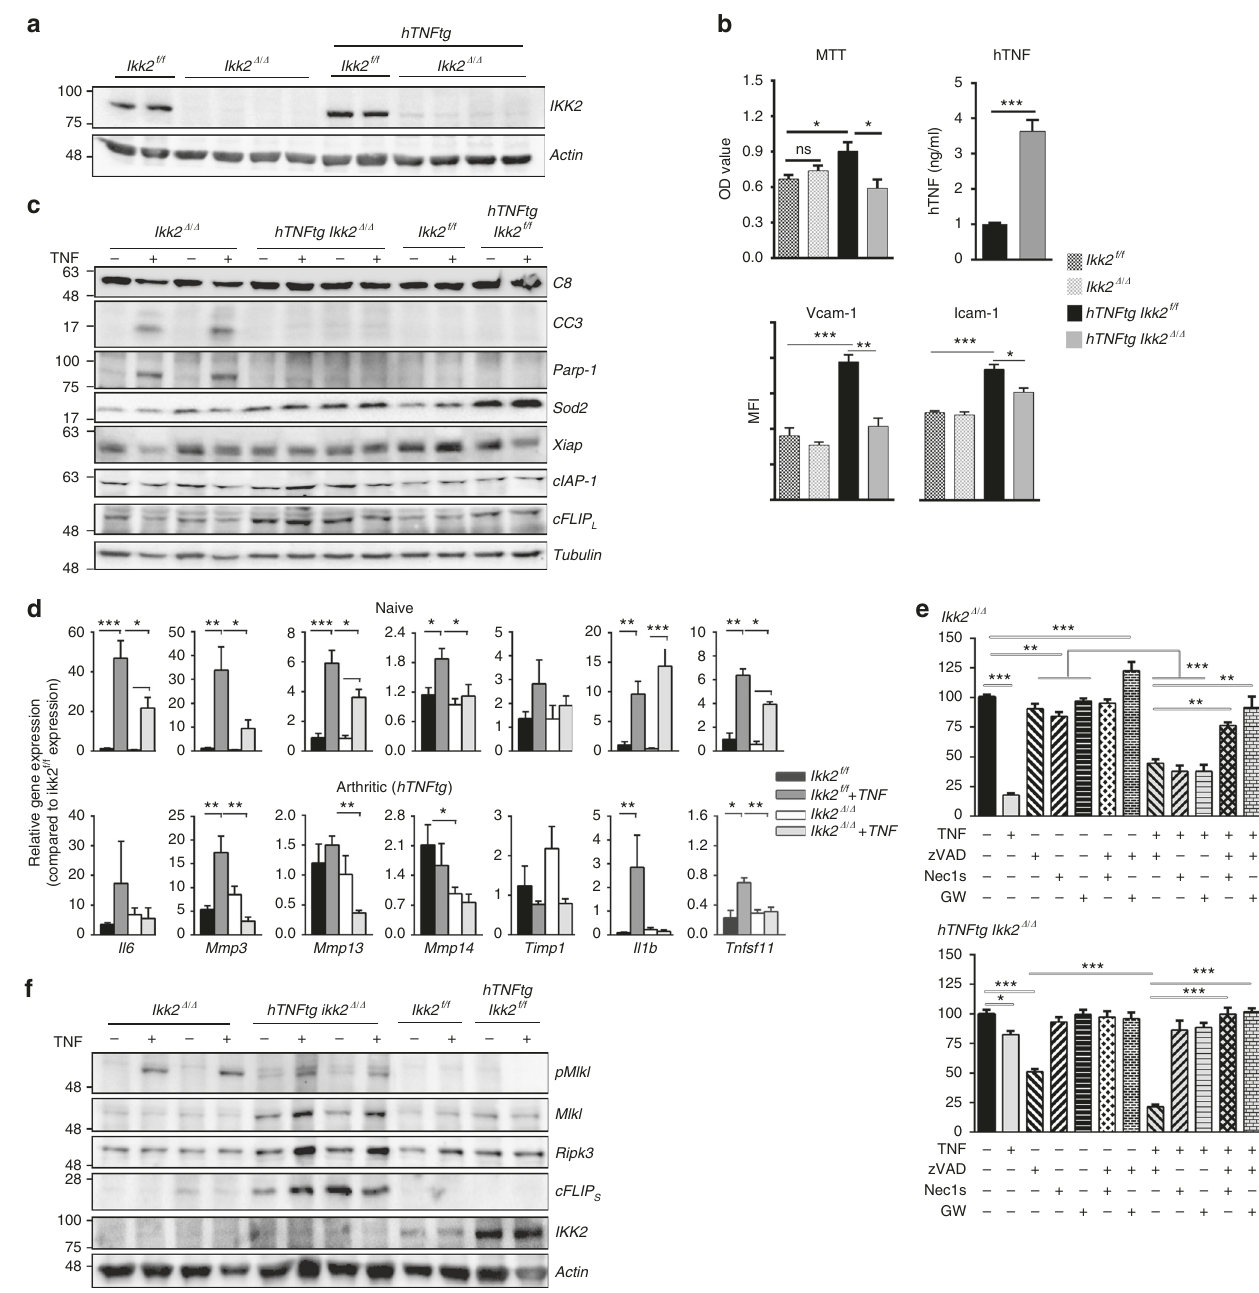
Fig. 4 IKK2 de fi ciency differentially affects gene expression of naive and arthritic SFs. a Representative immunodetection of IKK2 levels in TAT-Cre treated Ikk2 f/f ( Ikk2 Δ / Δ ) and TAT-Cre treated hTNFtg Ikk2 f/f ( hTNFtg Ikk2 Δ / Δ ) SFs compared to non-treated control cultures Ikk2 f/f and hTNFtg Ikk2 f/f , respectively (upper panel). b Representative MTT incorporation assay in the indicated genotypes; hTNF quantitation in the supernatants of hTNFtg Ikk2 Δ / Δ (grey column) and control hTNFtg Ikk2 f/f SF cultures (black column) ( n = 7, 2 experiments); fl ow cytometric detection of Vcam-1 and Icam-1 levels in cultured hTNFtg Ikk2 f/f (black), hTNFtg Ikk2 Δ / Δ (grey) and control SFs ( Ikk2 f/f : dotted black and Ikk2 Δ / Δ : dotted grey) ( n = 4, 2 experiments). c Representative immunodetection of Casp8 (C8), Cleaved Casp3 (CC3), Parp1, Sod2, Xiap, cIAP-1 and cFLIP (L) in cell extracts of Ikk2 Δ / Δ , hTNFtg Ikk2 Δ / Δ and control SF cultures treated with TNF (20 ng/ml, 5 h) ( n = 10). d Relative gene expression of the NF κ B-regulated genes Il6 , Mmp-3 , -13 , -14 , Timp1 , Il1b and Tnfsf11 (RankL) (normalized to b2m levels) in SFs of the indicated genotypes upon TNF (20 ng/ml, 5 h) ( n = 3 – 8). e Survival rates of Ikk2 Δ / Δ and hTNFtg Ikk2 Δ / Δ SFs treated with TNF, zVAD, Nec1s and GW806742X (GW) as indicated ( n = 3). f Representative immunodetection of pMlkl, Mlkl, Ripk3, cFLIP (S) and IKK2 levels in TNF-treated Ikk2 Δ / Δ , hTNFtg Ikk2 Δ / Δ and control SF cultures (TNF: 20 ng/ml, 5 h) ( n = 8, 4 experiments). Data are presented as the mean ± SEM. * P < 0.05, ** P < 0.01 and *** P < 0.001, by two-tailed Student ’ s t -test ( b , d ) or one-way ANOVA ( e ). Unprocessed original scans of blots are shown